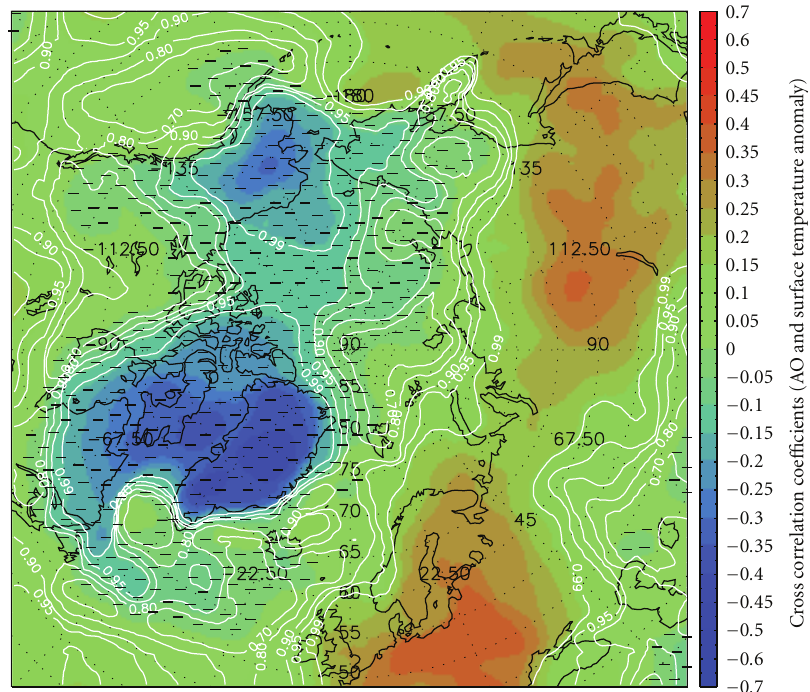
Figure 16: Correlation between the AO index and surface temperature anomalies from 276 months during the period 1982–2004. Contours in the image are confidence levels.